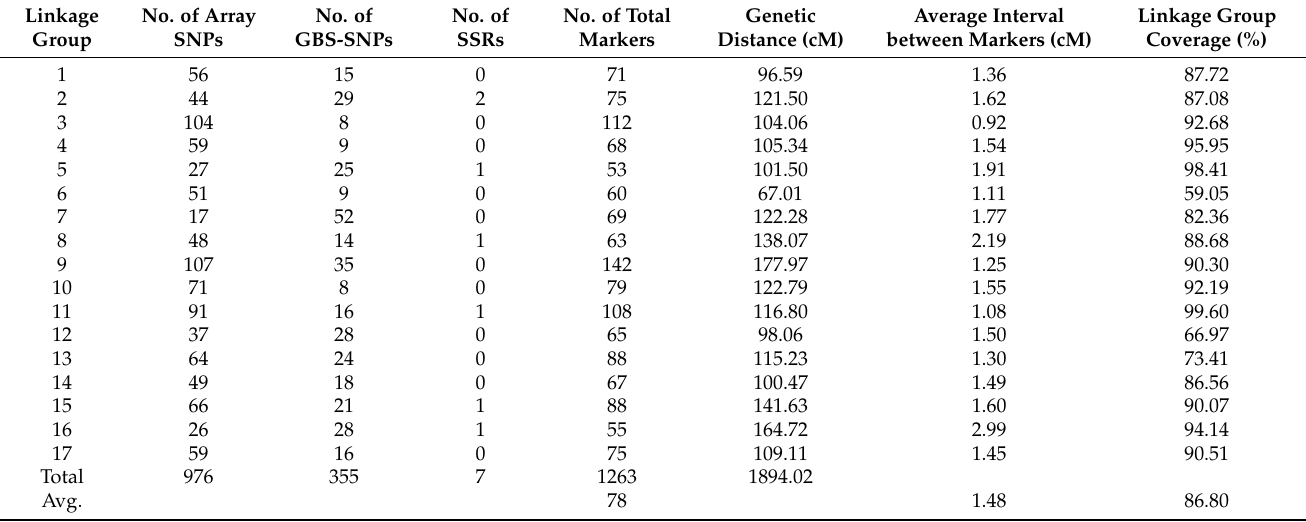
Table 1. The number of anchored markers, genetic distance, and marker density on the genetic linkage map of ‘Whangkeumbae’ ×